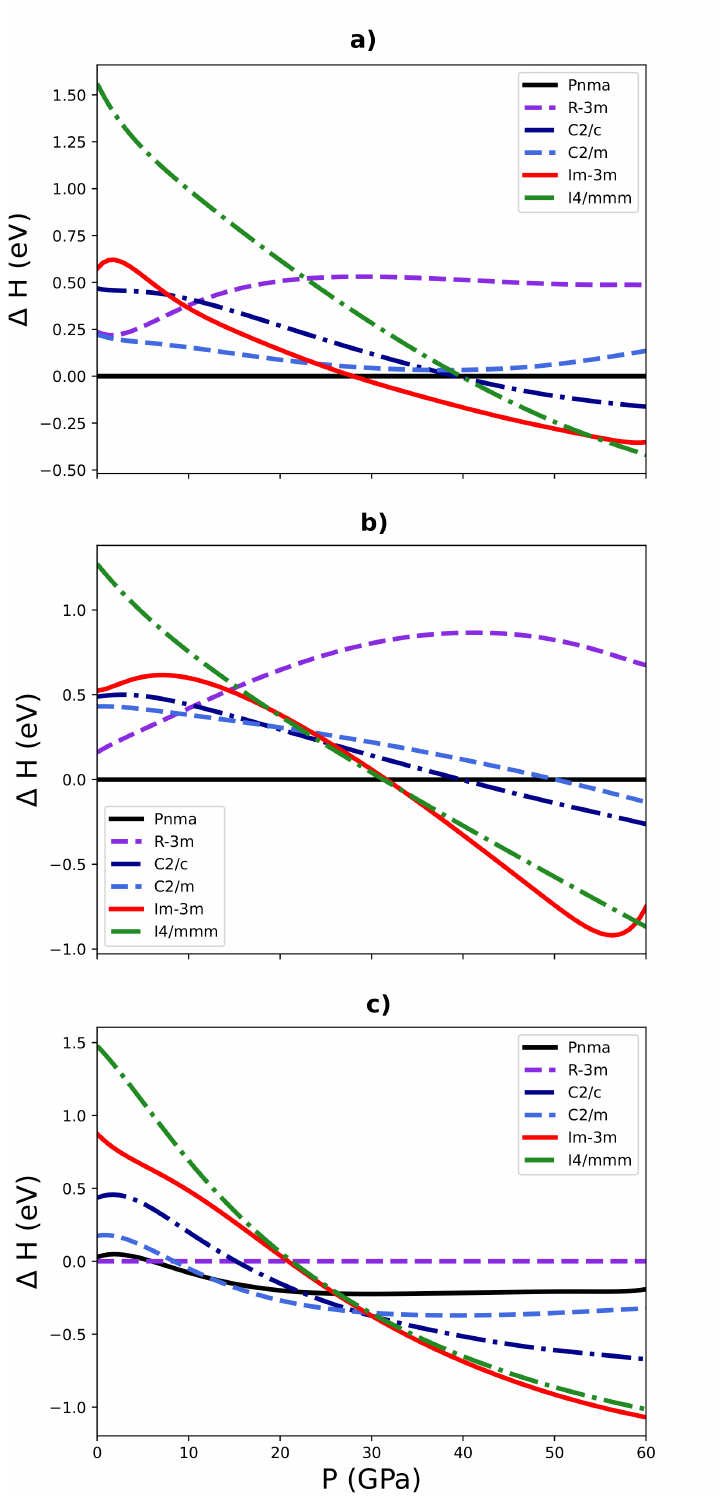
Figure A1. PBE+vdW enthalpy vs. pressure curves, for the different possible phases (shown in Figure 1) of Sb 2 S 3 ( a ), Bi 2 S 3 ( b ), and Sb 2 Se 3 ( c ), relative to the lowest-energy phase at ambient pressure: the Pnma phase for Sb 2 S 3 and Bi 2 S 3 , and the R-3m phase for Sb 2 Se 3